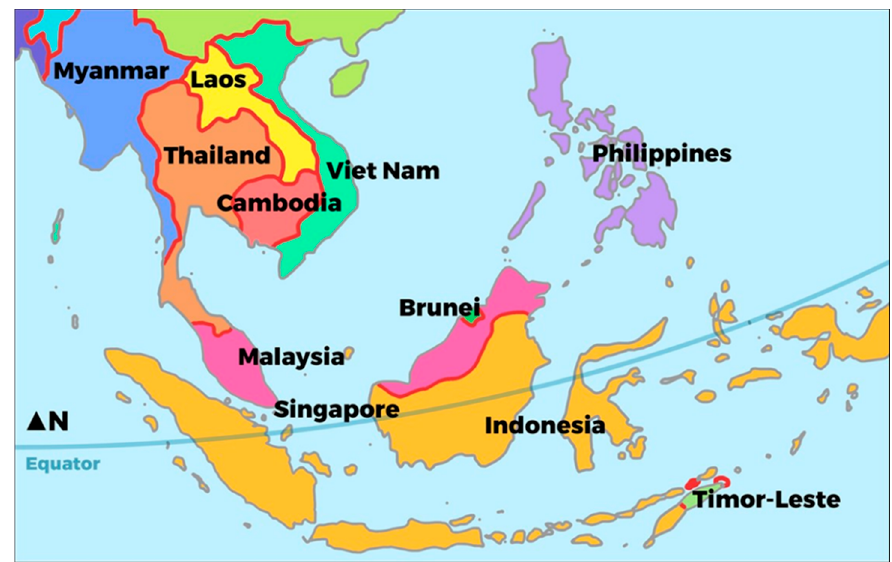
Figure 4. Map of Southeast Asia showing the relative sizes and locations of the eleven countries used in the case study. Table 1. Total population [13], percent level of urban population [16] and GDP per capita [15] for the eleven countries in the case study based on 2017 data.